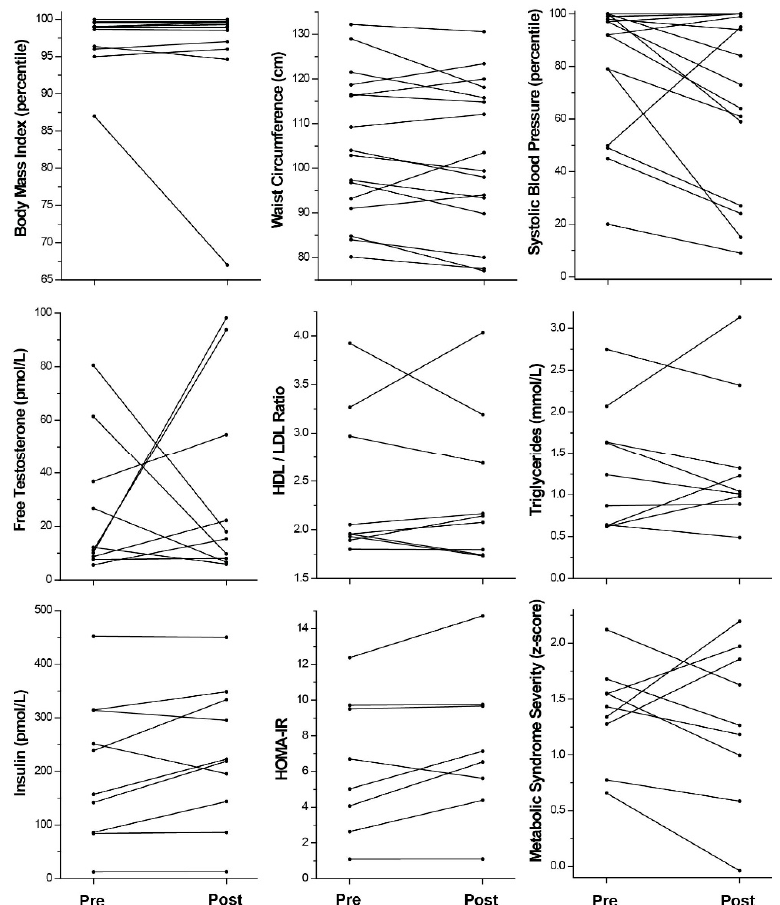
Figure 2. Individual results.